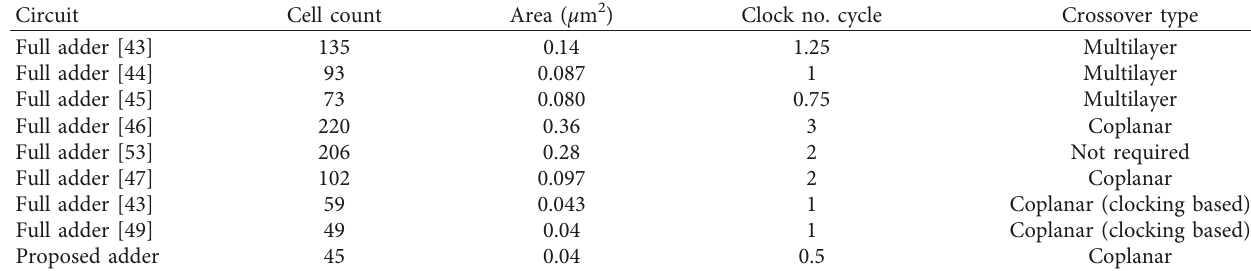
Table 1: Comparison of the proposed adder with the previous works.